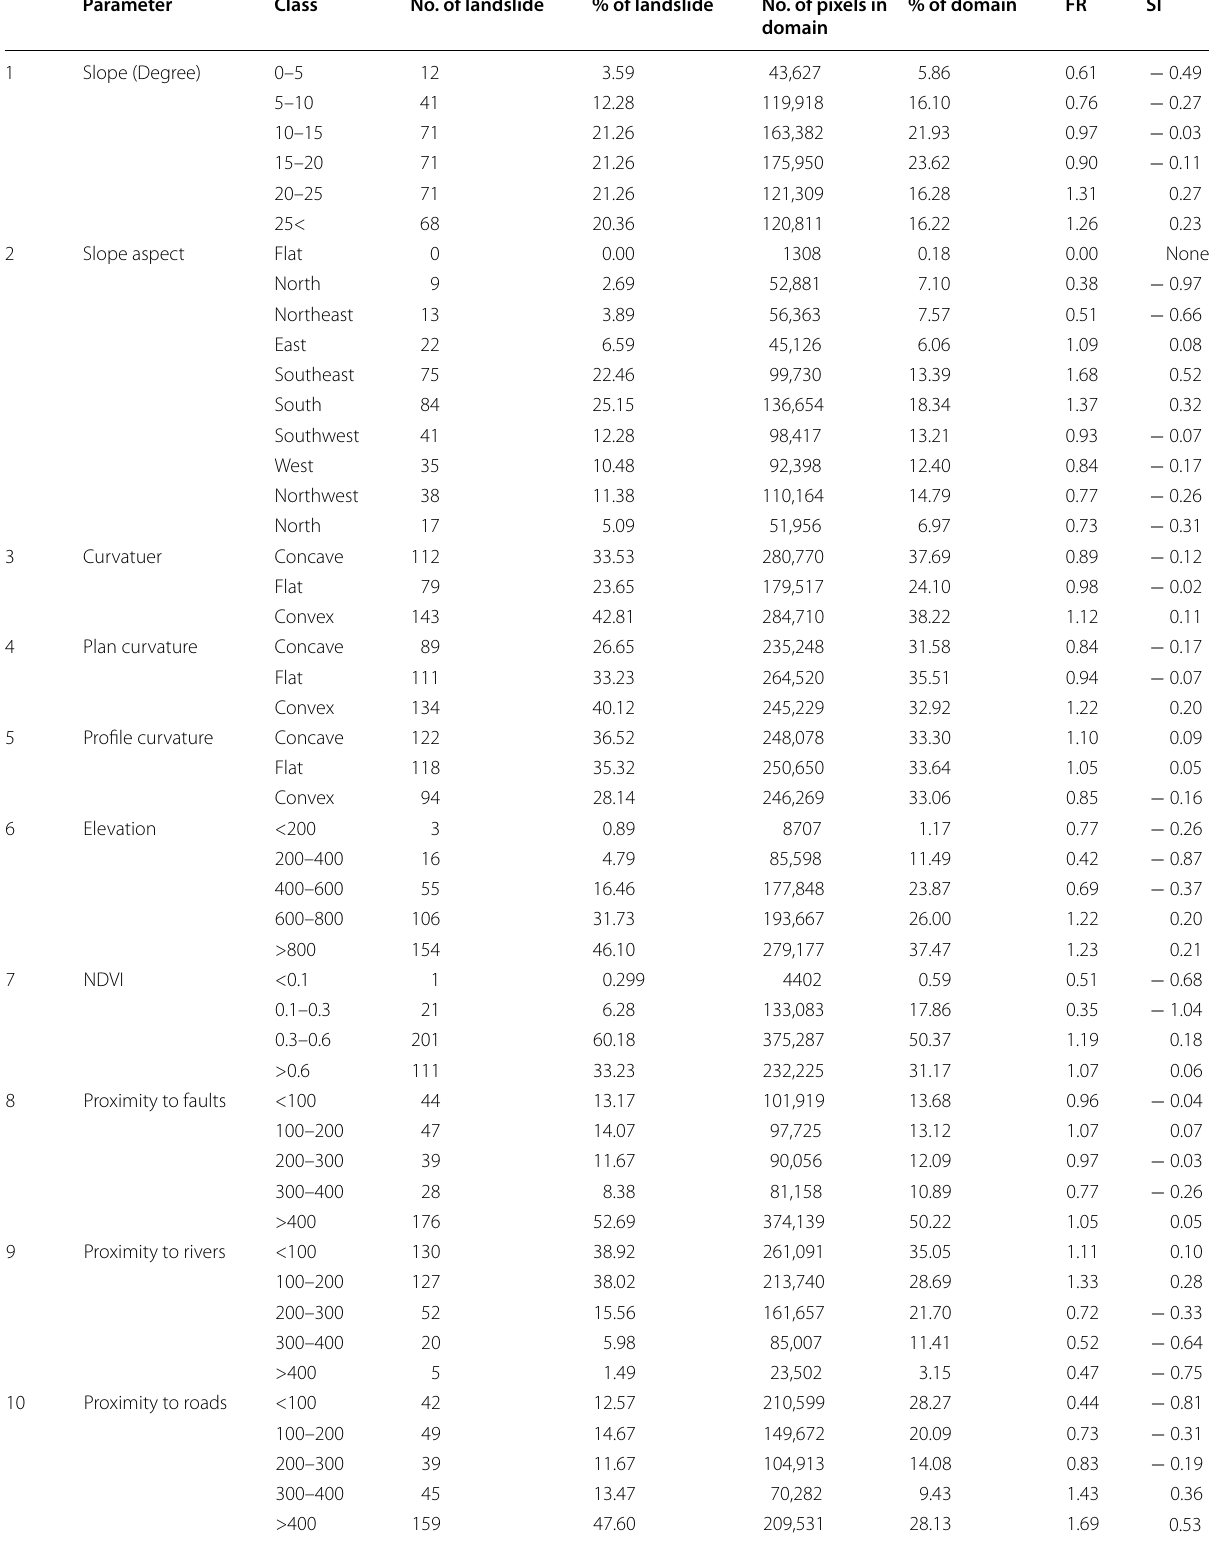
Table 3 The linking between classes of landslide causative criteria and present landslide events by FR